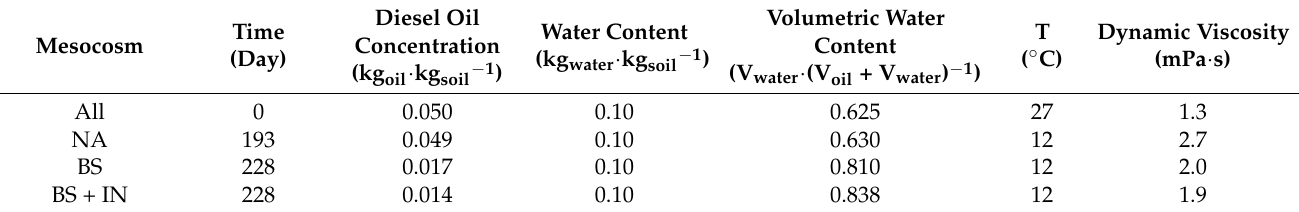
Table 3. Dynamic viscosity of diesel oil-water mixture in the tested mesocosms.